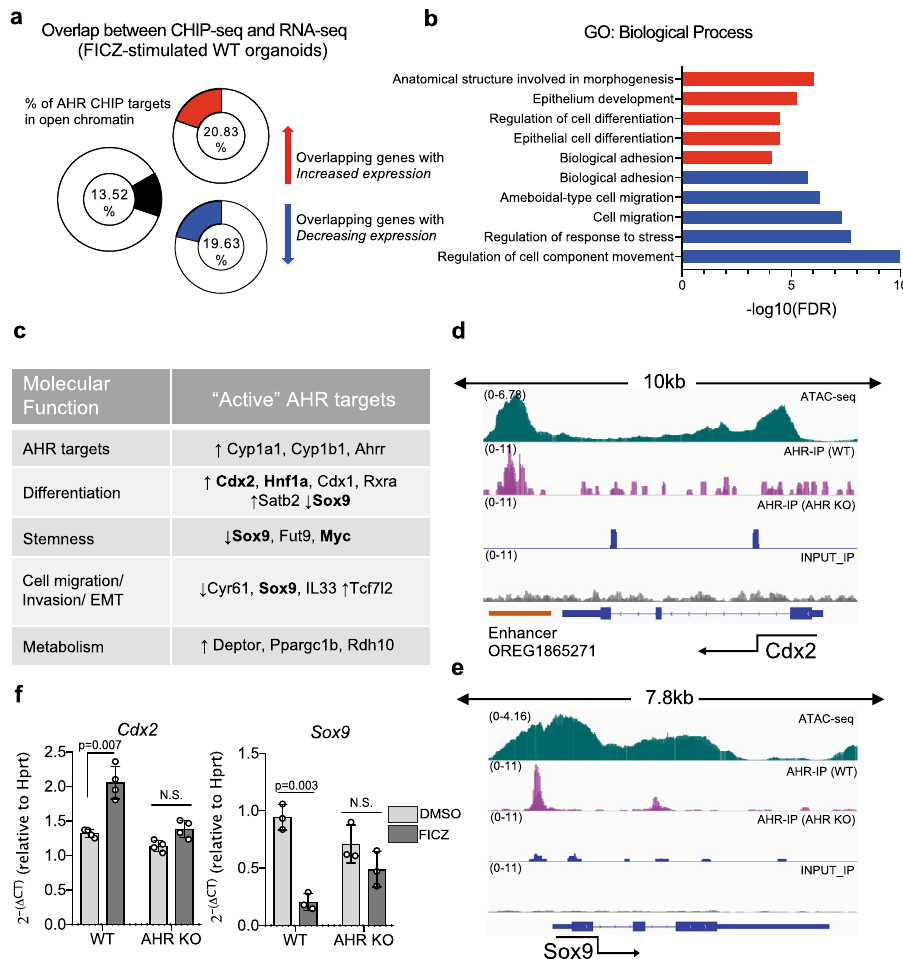
Fig. 6 AHR regulates key factors involved in regenerative response. a Overlap between identi fi ed AHR ChIP targets in open chromatin regions with genes up or downregulated in response to FICZ from RNA-sequenced WT organoids (4h-post FICZ treatment). b Functional annotation of activated (red) or repressed (blue) AHR targets using GO ontology analysis (GO biological process) ( c ) Selection of active AHR targets with their associated functions. Targets that were also identi fi ed by the IPA upstream regulator analysis in d4 ENR AHR KO organoids are in bold (see Fig. 2 C). d IgV graphs showing sites of AHR binding in an enhancer element of Cdx2 and and ( e ) AHR binding to the Sox9 promoter. f qPCR expression data of Cdx2 and Sox9 in WT and AHR KO organoids treated with FICZ (4 h). Statistical signi fi cance was determined by two-way ANOVA with Sidak ’ s multiple comparison test. P value of >0.05 was considered not signi fi cant (n.s.). n = 4 and n = 3 mice per genotype were used for Cdx2 and Sox9 qPCRs respectively. Error bars displayed on graphs represent the mean ± SD of at least two independent experiments. Source data for (6 a – c , f ) are provided with this paper in the source data fi